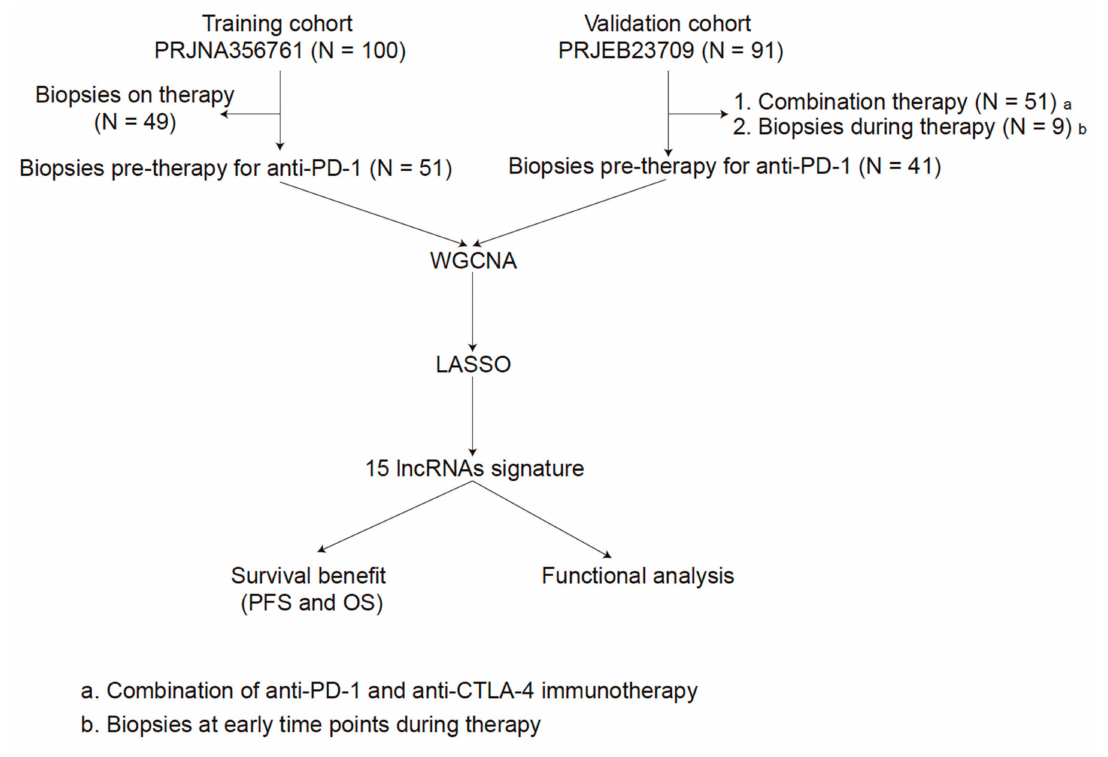
Figure 1. The overall workflow of this